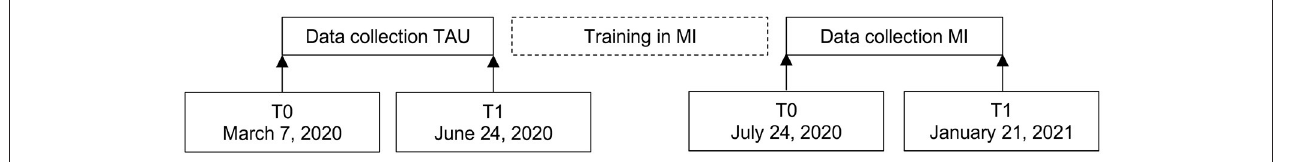
FIGURE 1 | Study design and